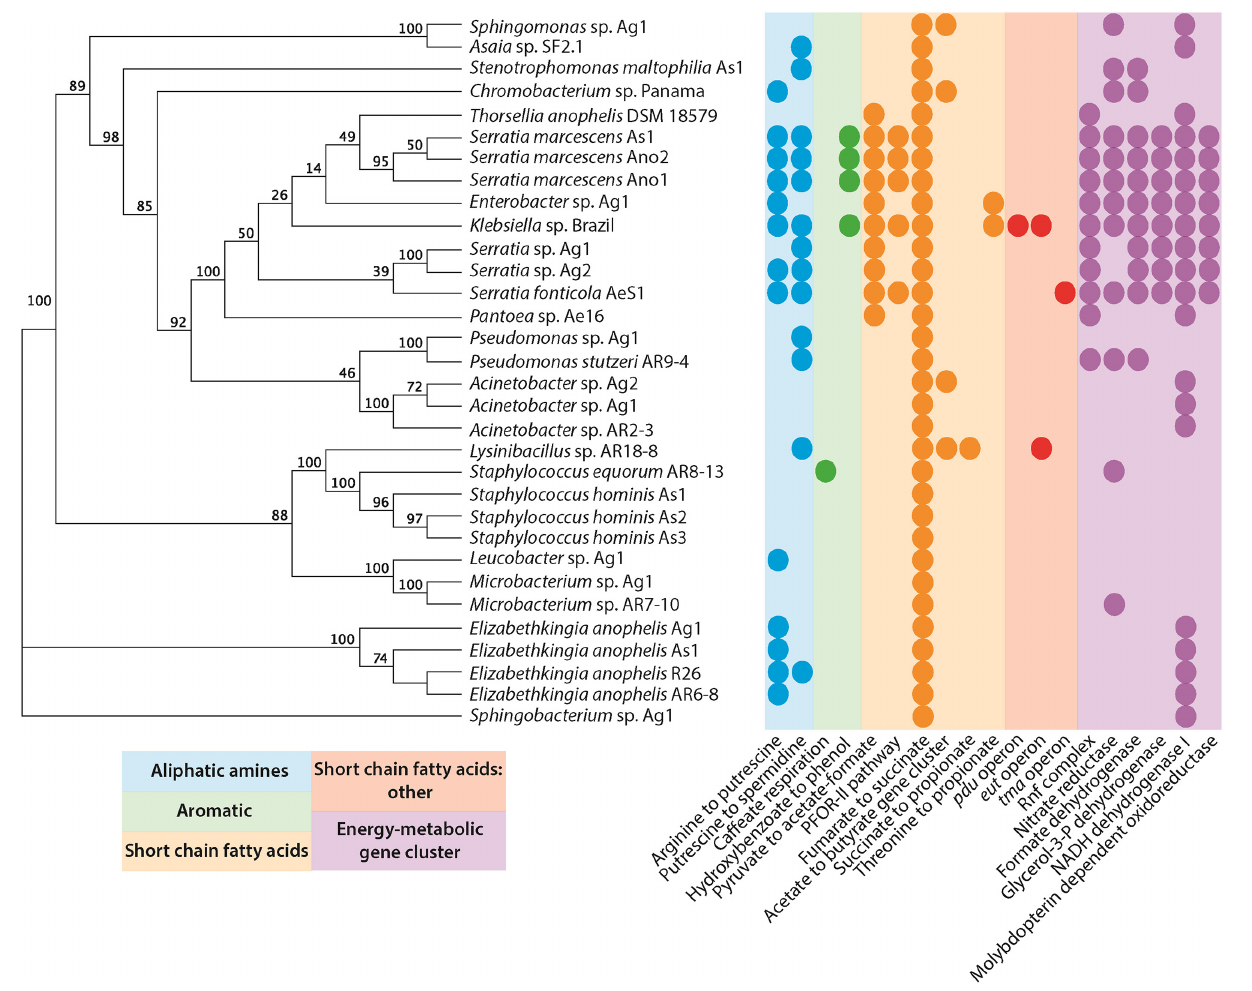
FIGURE 2 | Primary metabolic pathways present in bacteria isolated from mosquitoes ( Supplementary Table 1 ). Genomes were submitted to gutsmash (https://gutsmash.bioinformatics.nl/) to identify metabolic pathways related to the production of aliphatic amines, aromatic compounds, short-chain fatty acids, or energy metabolic clusters. Circles represent the presence of at least a single copy of the labeled pathway. The tree represents a maximum likelihood phylogeny based upon the 16S rRNA sequence with 100